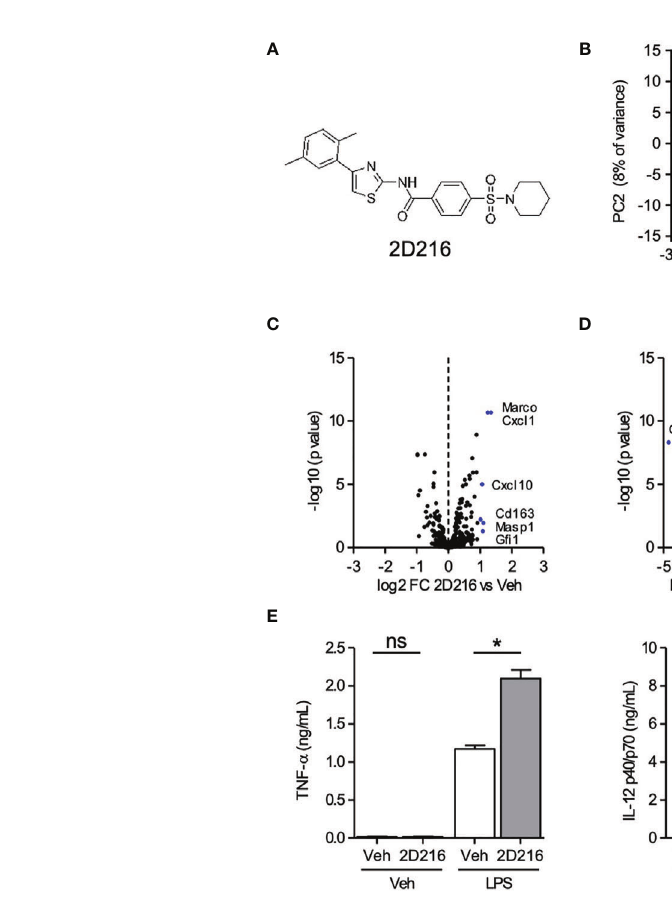
FIGURE 1 | Augmentation of TLR4 ligand-mediated activation of mBMDCs by 2D216 . (A) Chemical structure of compound 2D216 . (B – D) nCounter gene expression analysis of genes upregulated by LPS/ 2D216 and LPS. mBMDCs (1×10 6 cells/mL) were incubated with vehicle (Veh), 2D216 (5 m M), LPS (1 ng/mL), or 2D216 (5 m M) plus LPS (1 ng/mL) for 5 h, and total RNAs were subjected to nanoString nCounter ® Mouse Immunology Panel analysis containing 561 mouse immune-related genes. (B) PCA demonstrates the clustering of the treatments. (C) Genes signi fi cantly up-regulated by 2D216 compared to Veh and (D) LPS/ 2D216 compared with LPS alone are shown as blue dots (log2 FC > 1 and FDR < 0.05). (E) Cytokine secretion induced by 2D216 . mBMDCs (0.5×10 6 cells/mL) were incubated with Veh, 2D216 (5 m M), LPS (1 ng/mL), or LPS (1 ng/mL)/ 2D216 (5 m M) plus LPS (1 ng/mL) for 20 h, and the levels of IL-12 p40/p70 and TNF- a in the LPS/ 2D216 culture supernatants were signi fi cantly greater than LPS alone. Data represent mean ± SD of triplicates of two independent experiments showing similar results. *p < 0.05 by Mann-Whitney U test compared to Veh/Veh or MPLA/Veh. ns, not signi fi